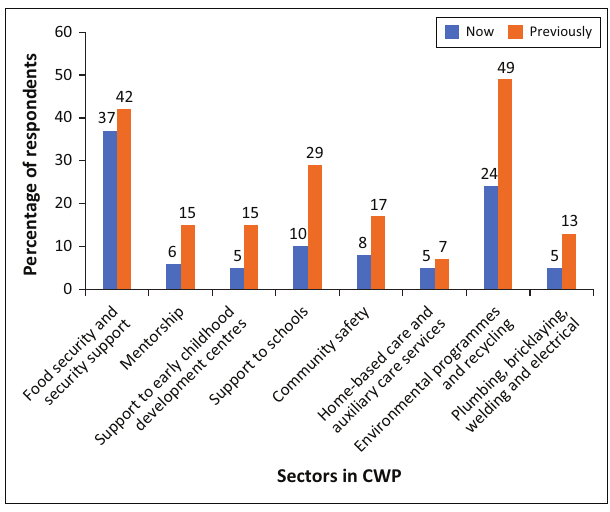
FIGURE 2: Respondents’ employment in community work programme